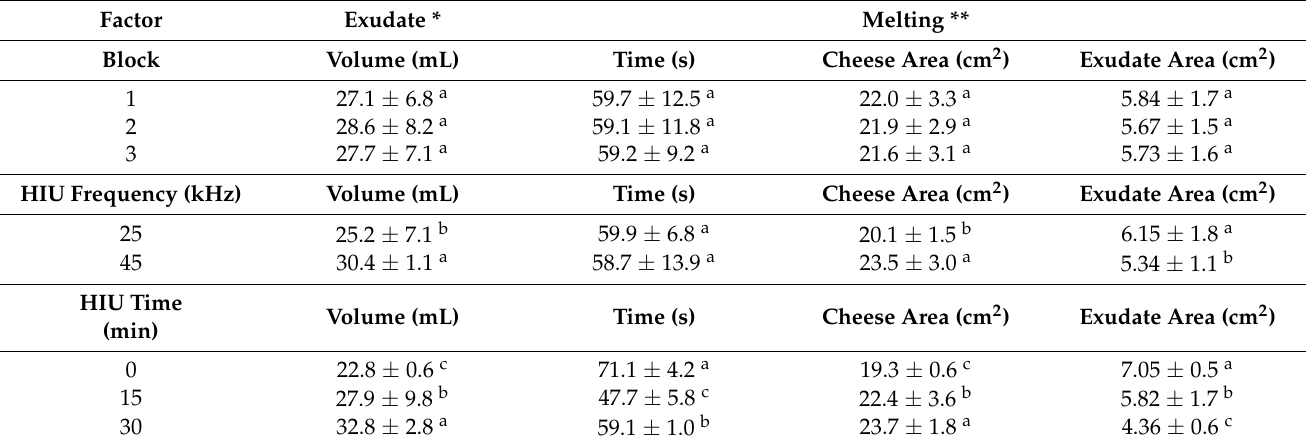
Table 2. Effects of blocks, frequency, and application time of ultrasonication on the volume of exudate and melting of Oaxaca cheese.